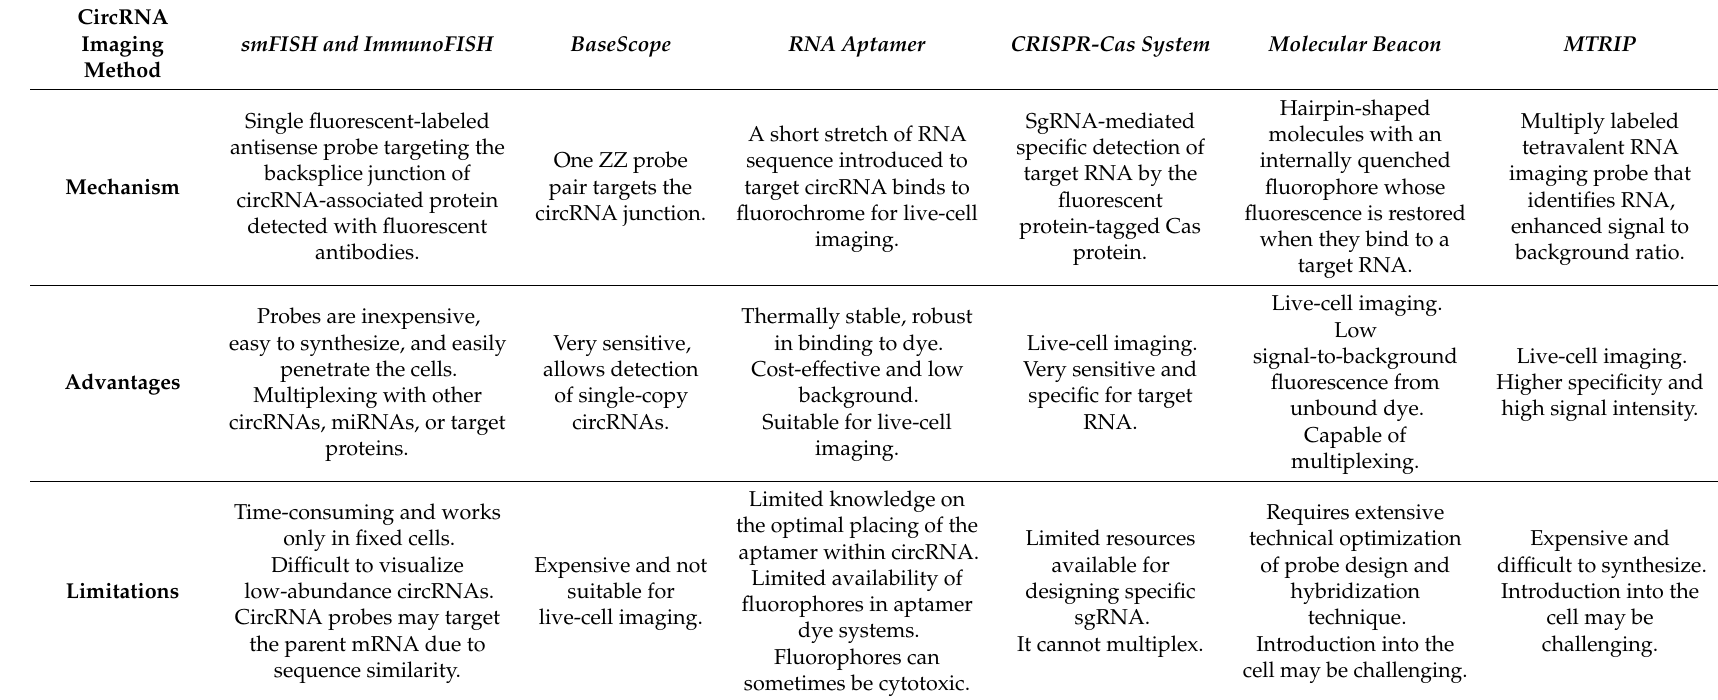
Table 2. Overview of various circRNA imaging